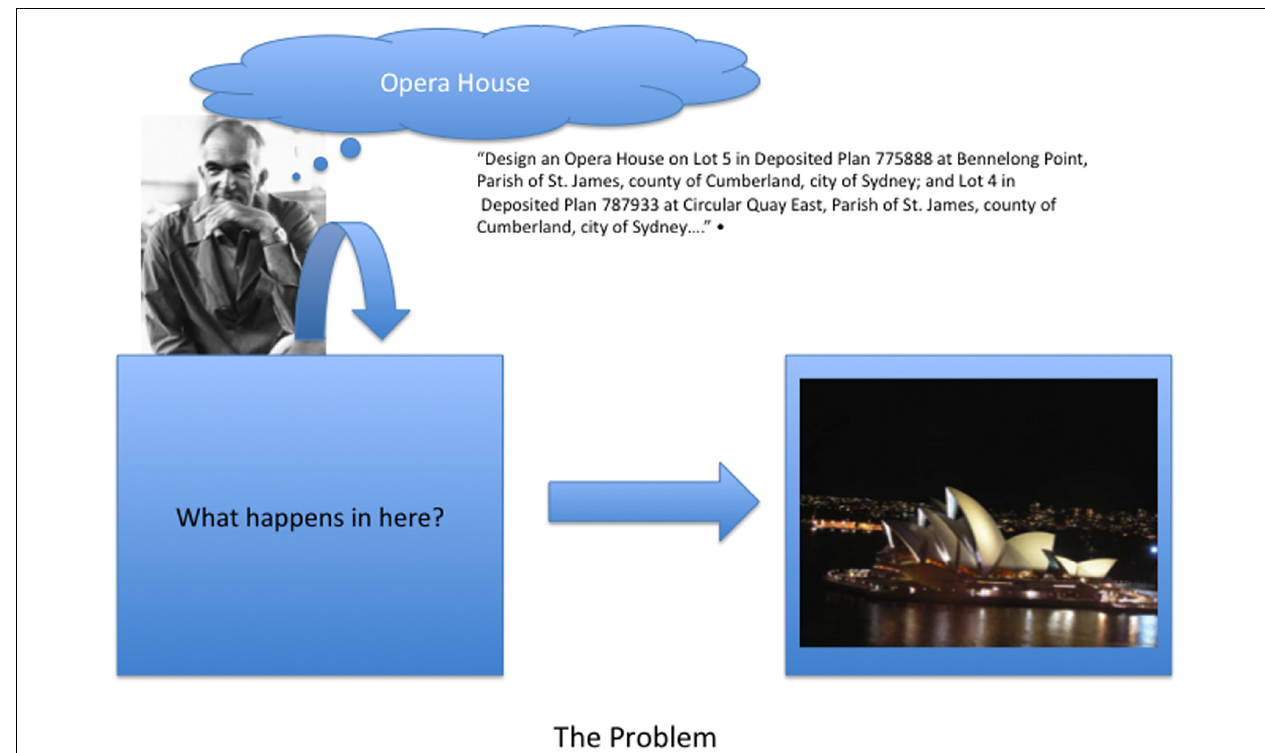
FIGURE 1 |The input to the designer is a design brief, the output are the contract documents specifying the artifact. The problem of interest is what cognitive and neurological structures and processes support the transformation of the input to the